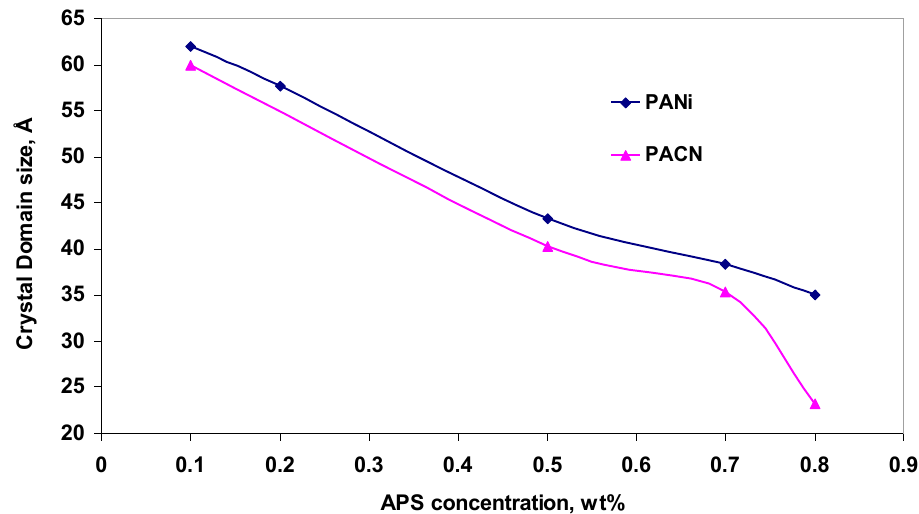
Figure 10. Effect of oxidant concentration on the crystal domain size, showing decreasing crystal domain size with increasing oxidant, APS, concentration.